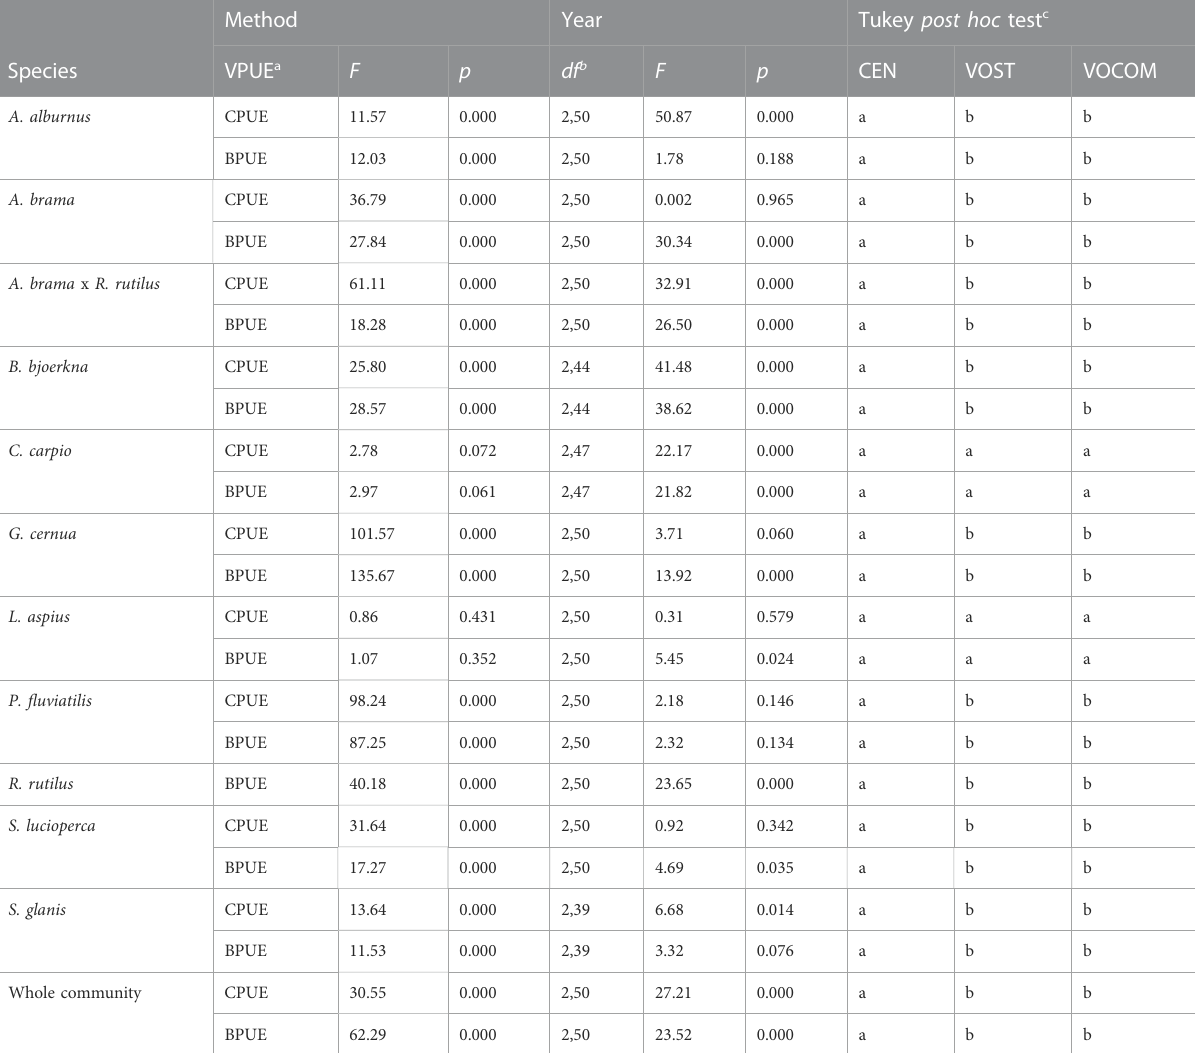
TABLE6Summaryofcomparisons(ANCOVAandTukey posthoc test)forestimatedVPUEsof fi shcommunitysampledindifferentyears(2004 – 2021)in Ř ímov Reservoir (Czech Republic) derived from CEN, VOST and